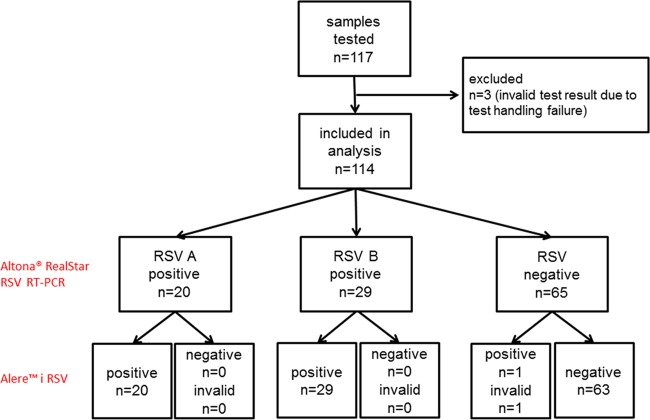
Study flow chart.